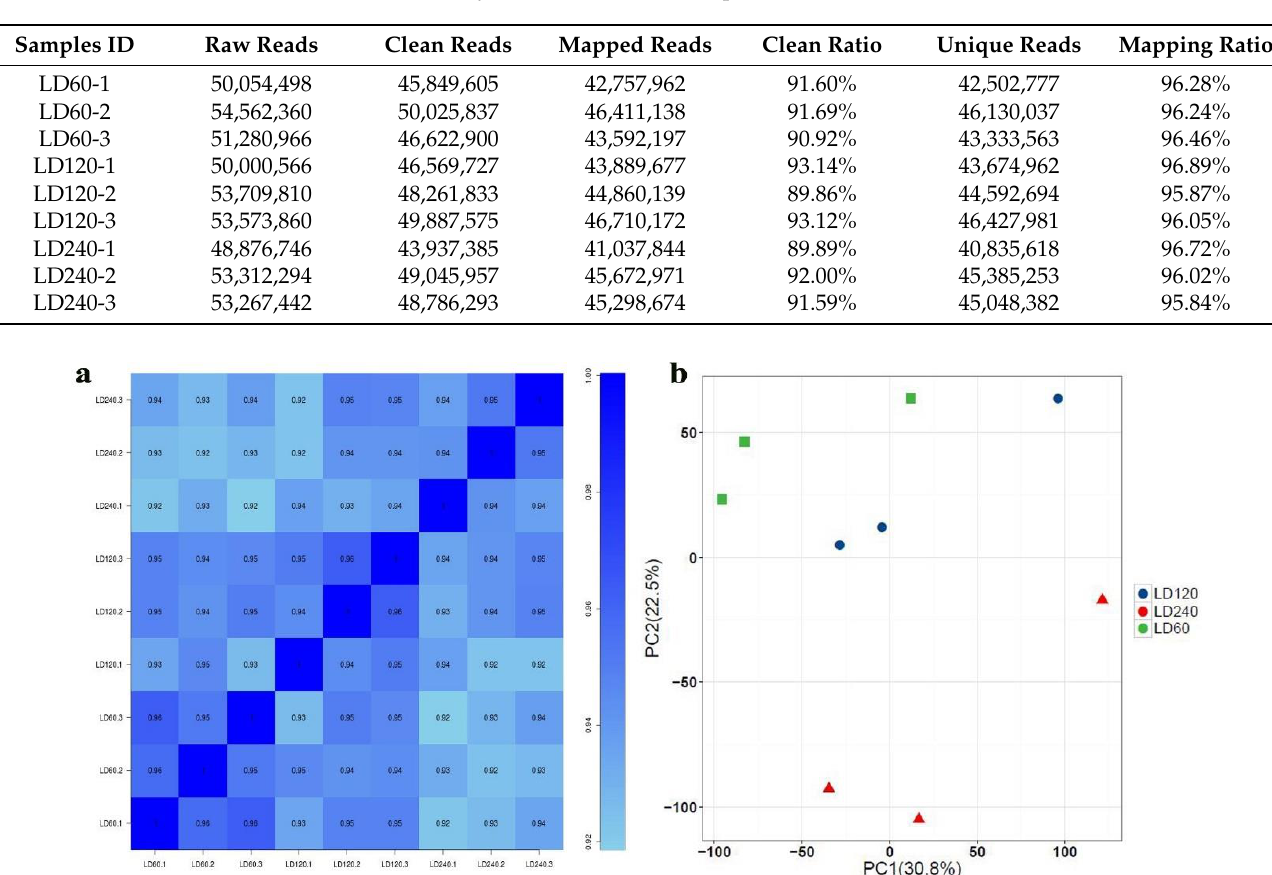
Table 2. Summary statistics of the transcriptome.